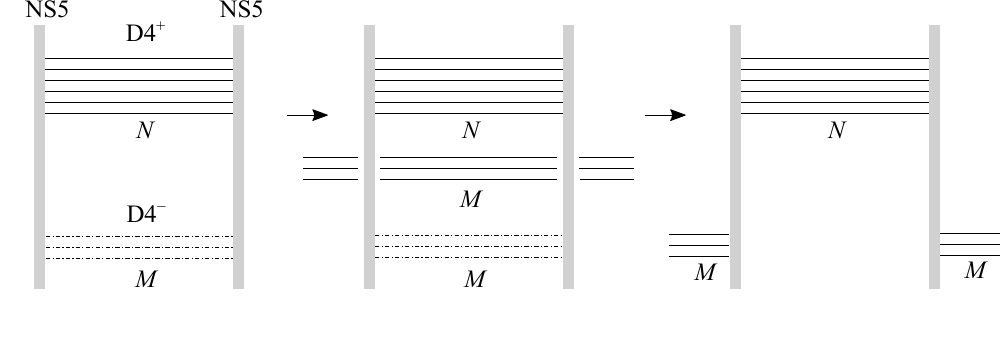
Figure 13 . A con(cid:12)guration of positive and negative D4-branes suspended between two NS5-branes that reproduces a SU( N j M ) gauge theory. This con(cid:12)guration can be deformed to a SU( N ) theory with 2 M